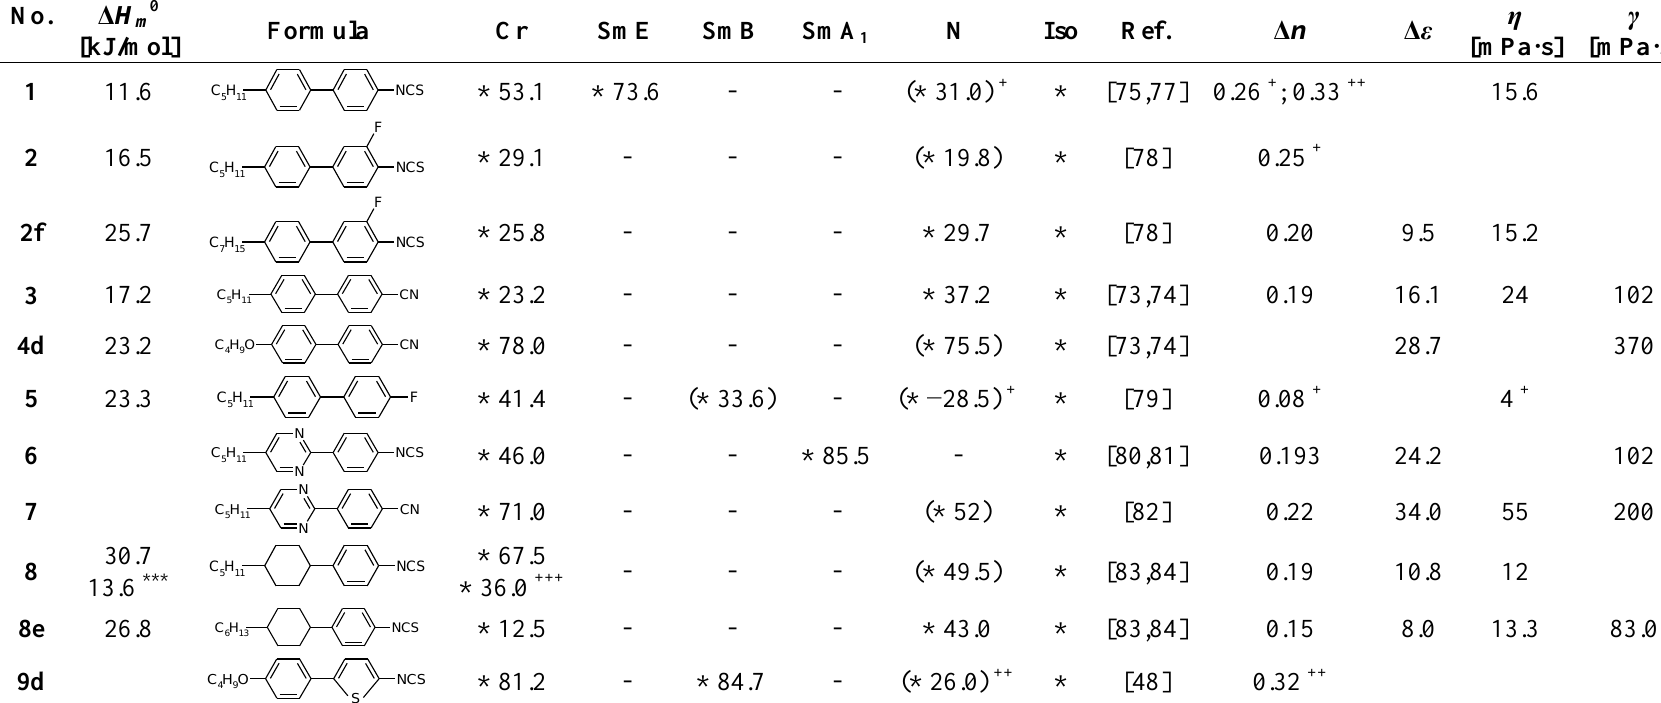
+ virtual N–I transition temperature and properties estimated from solution in compound 8e ; ++ from solution in E7; +++ metastable form crystallizing during cooling from nematic